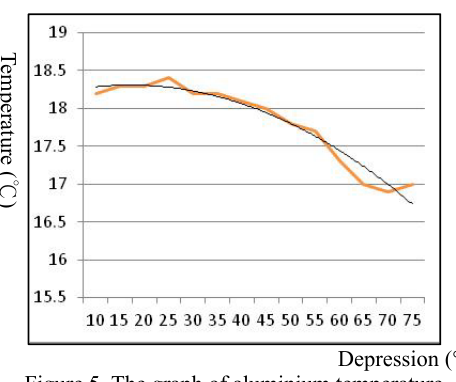
Figure 5. The graph of aluminium